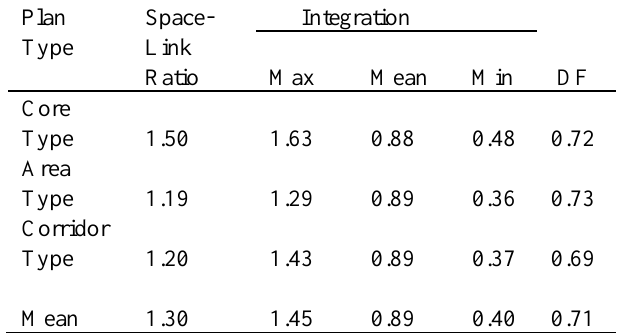
Integration, Space-link ratios, and difference factor of three